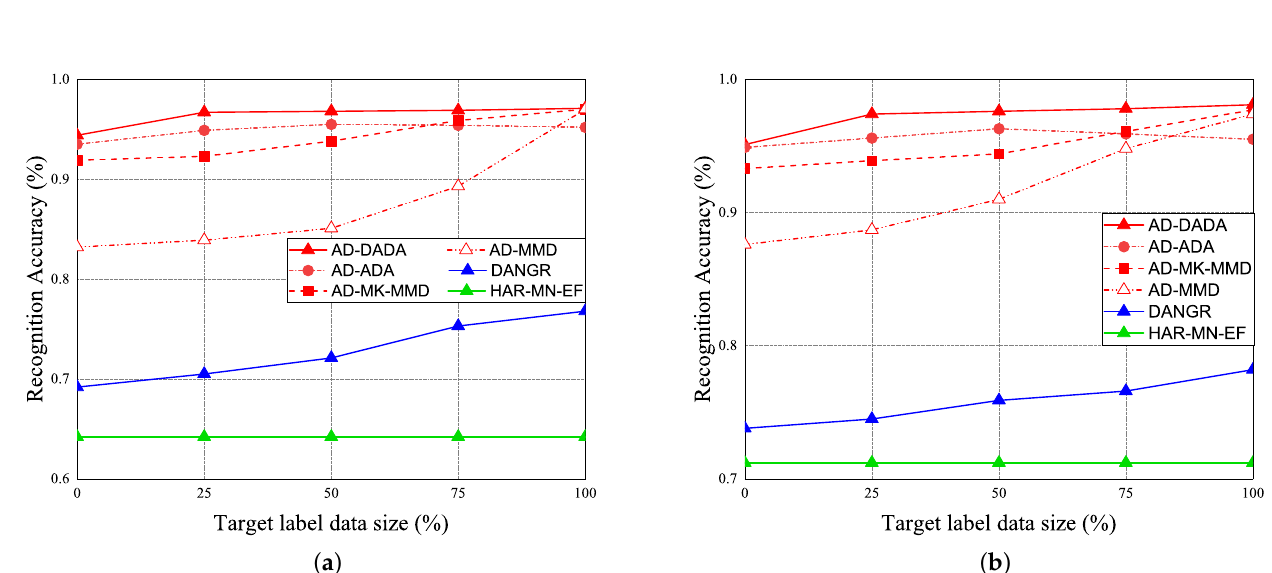
Figure 20. RA vs. various ratios of labeled data for ( a ) target (A) and ( b ) target (B) under target data ratio = (1:1:1:1:1). The performance of RA vs. epoch is given under ratios of labeled data = 0% (Figure 21a,b), ratios of labeled data = 25% (Figure 21c,d), and 100% (Figure 21e,f), under the target